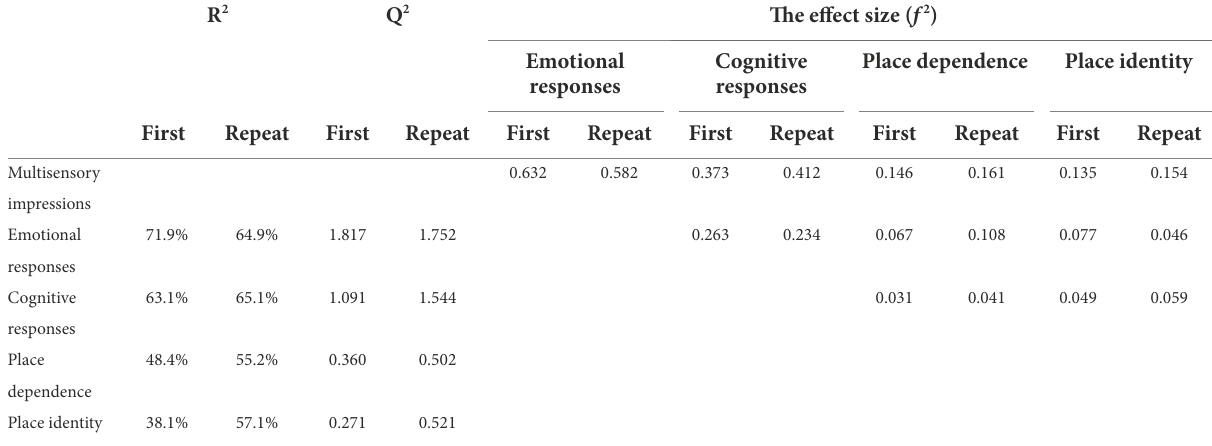
TABLE 3 Structural model test